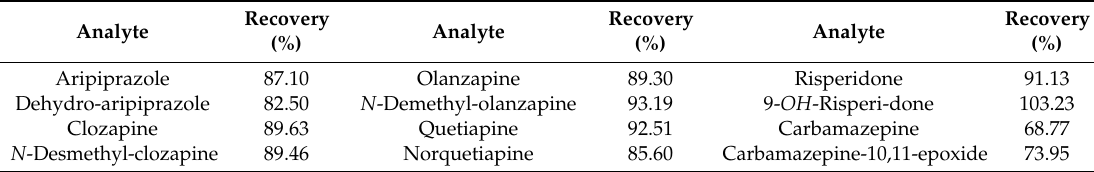
Table 2. Recovery values for analytes under